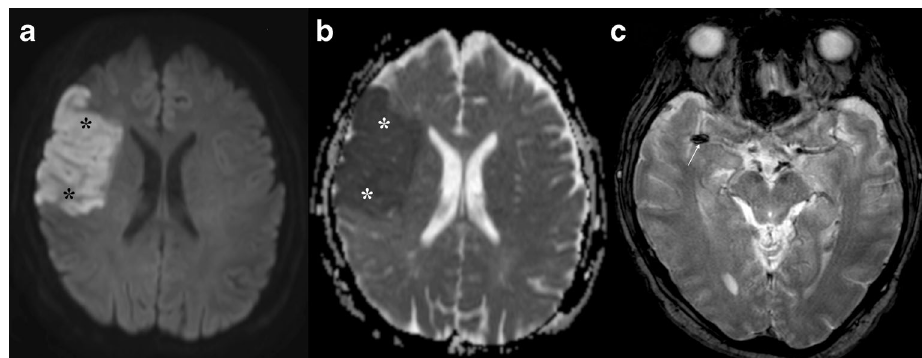
Fig. 1 Acute stroke. a Increased signal intensity on DWI in the territory of the right middle cerebral artery (MCA), which corresponds to an area of low ADC value in b (asterisks), representing the extension of an acute ischaemic stroke. c A clot as the aetiology, presenting as a linear hypointense abnormality in the MCA on T2*WI